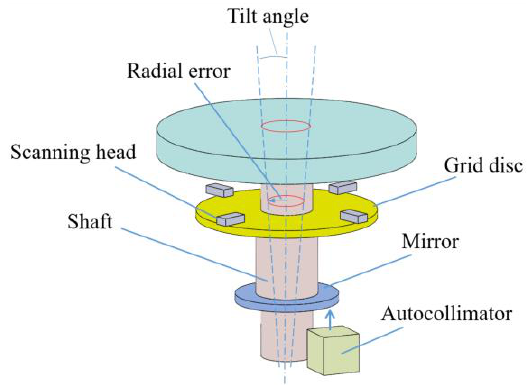
Figure 1. Measuring method for attitude error of the rotary stage.